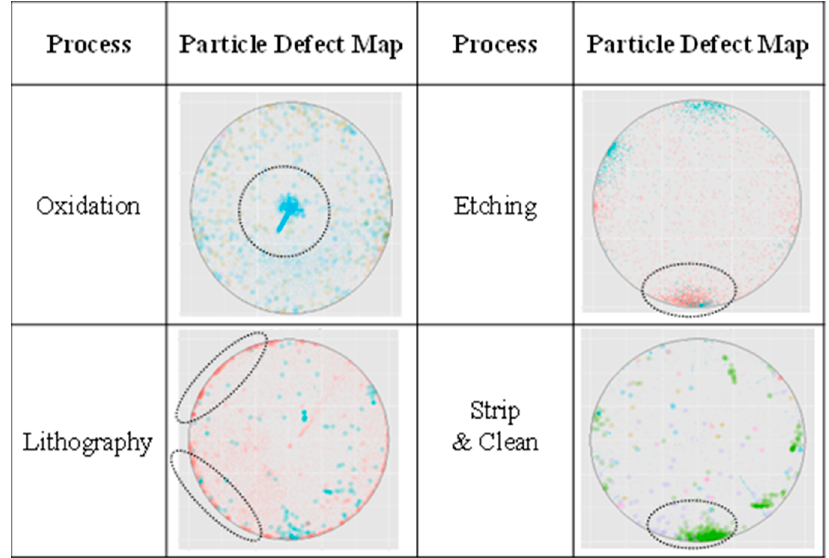
Figure 6. Particle maps of the four processes.